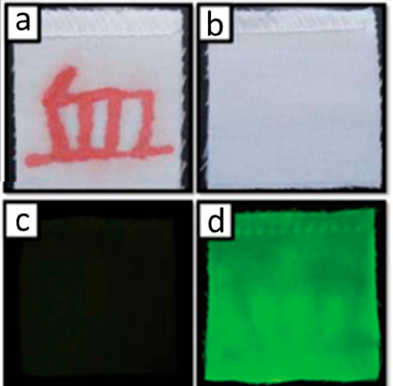
Figure 14. ( a ) Chinese character written in blood; ( b ) the bloodstained fabric after washing; ( c ) the washed fabric sprayed with C-dots and seen under natural light; ( d ) the C-dot-sprayed fabric seen under 460–490 nm light, showing darkening where traces of blood remain. Reproduced from reference [75] with permission from The Royal Society of Chemistry.